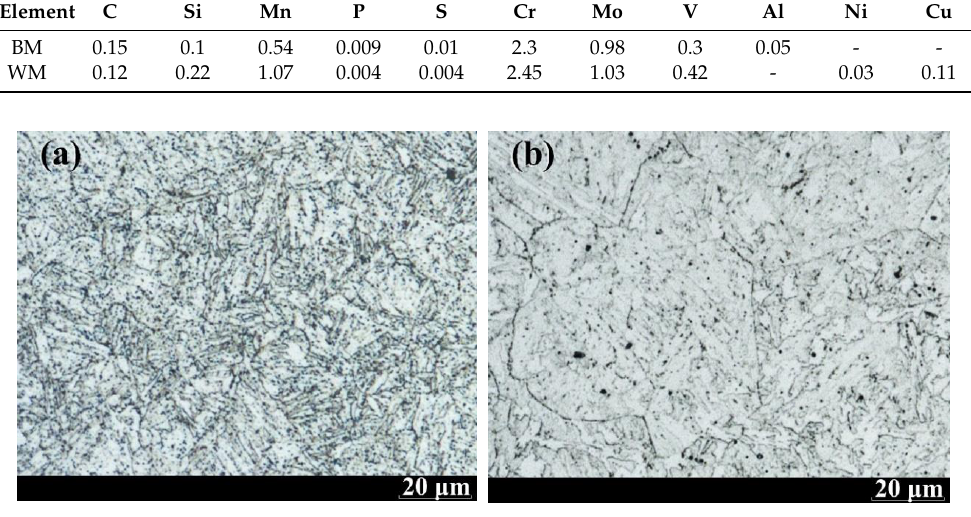
Figure 1. Optical microscopy (OM) images of 2.25Cr1Mo0.25V steel and weld: ( a ) base metal (BM) and ( b ) weld metal (WM).